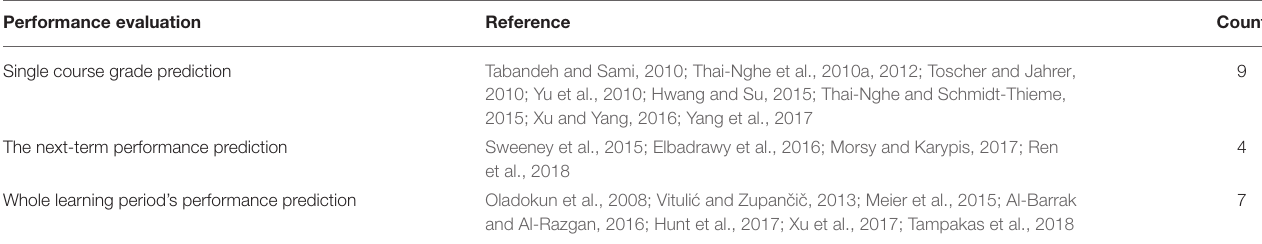
TABLE 3 | The list of references for performance